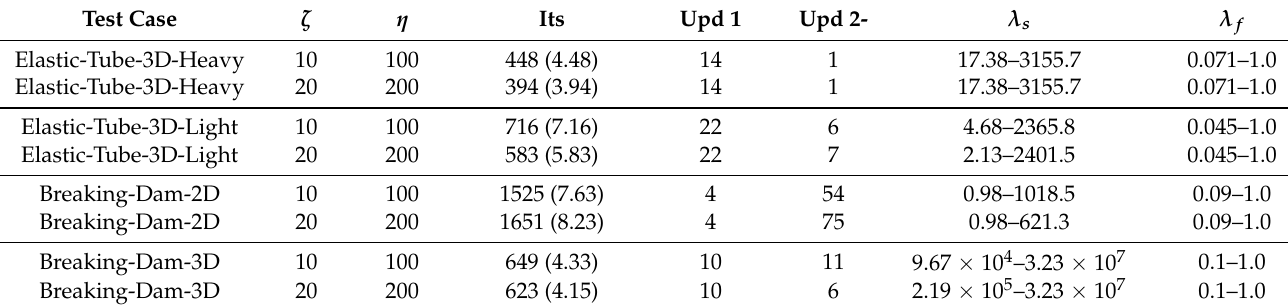
Table 2. Performance details of pre-scaling weight monitoring with QR3 filter ( (cid:101) f = 0.01). For